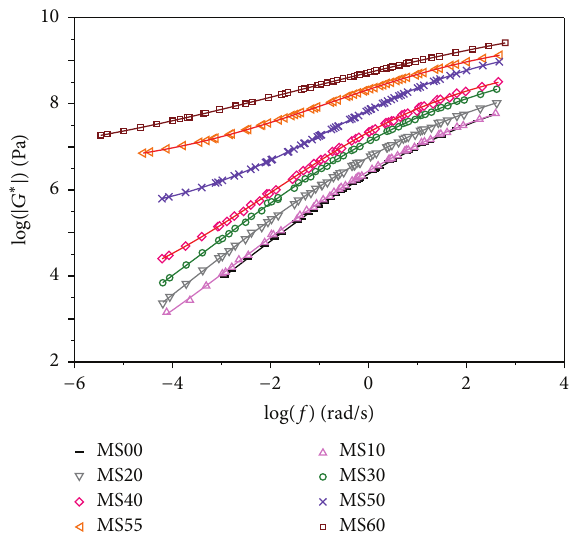
Figure 8: Relation between modulus ratio and filler volume frac-